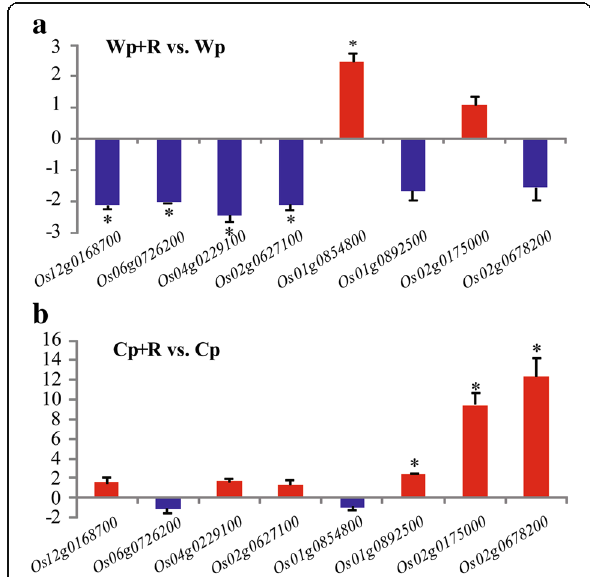
Fig. 5 Validation of the RNA-sequencing data using reverse transcription-quantitative real-time PCR (RT-qPCR). Eight genes were selected for RT-qPCR analysis from the RNA-sequencing data. a Relative expression of the selected genes in the ‘ Wp+R vs. Wp ’ comparison. b Relative expression in the ‘ Cp+R vs. Cp ’ comparison. Cp + R, Rhizoglomus intraradices -inoculated cultivated rice infected with M. oryzae ; Cp, R. intraradices -uninoculated cultivated rice infected with M. oryzae ; Wp + R, R. intraradices - inoculated wild rice infected with M. oryzae ; Wp, R. intraradices - uninoculated wild rice infected with M. oryzae . The error bars represent standard deviations of the means. The asterisks above the bars indicate significant change in gene expression at P <0.05 based on Student ’ s t